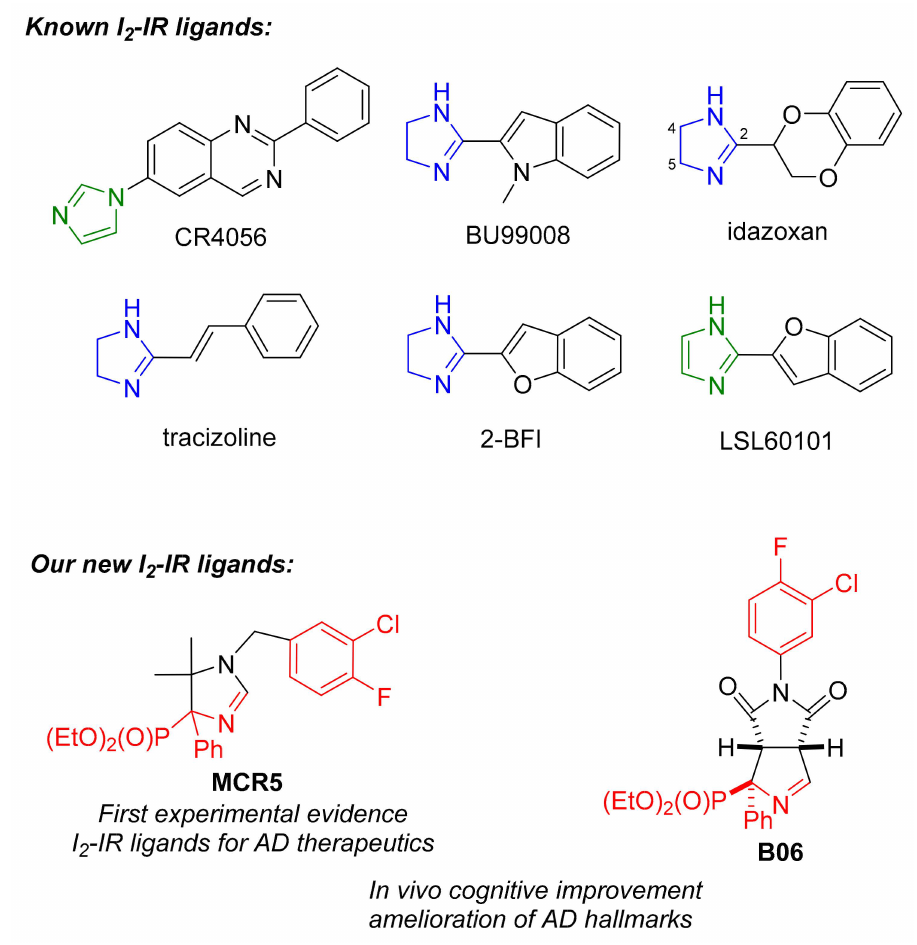
Figure 1. Structure of the known I 2 -IR ligands (2-imidazoline nucleus in blue and imidazole nucleus in green) and our representative new I 2 -IR ligands, MCR5 and B06